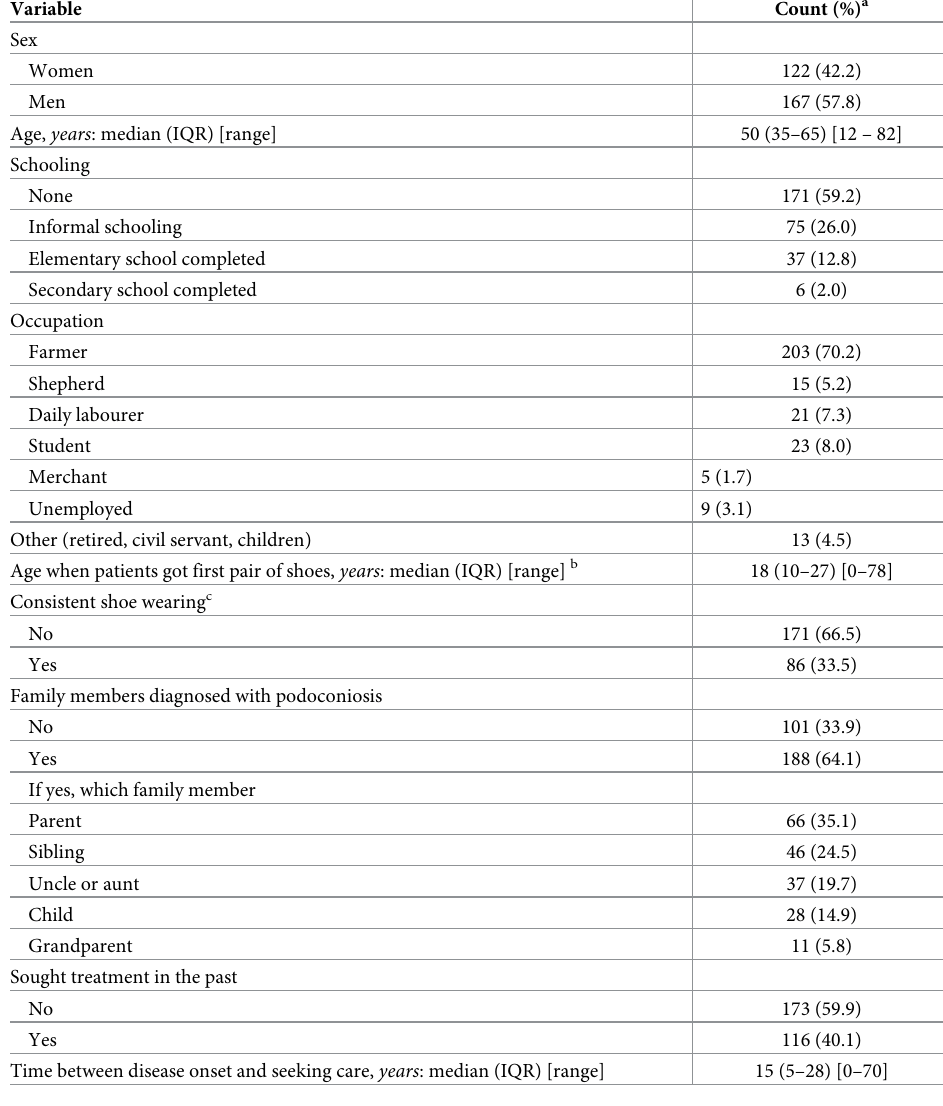
Table 1. Sociodemographic characteristics and medical history of patients with podoconiosis in Durbete Podoco- niosis Prevention and Treatment Center, Durbete, Ethiopia, February 2018 to October 2019 (n = 289). Variable Count (%) a